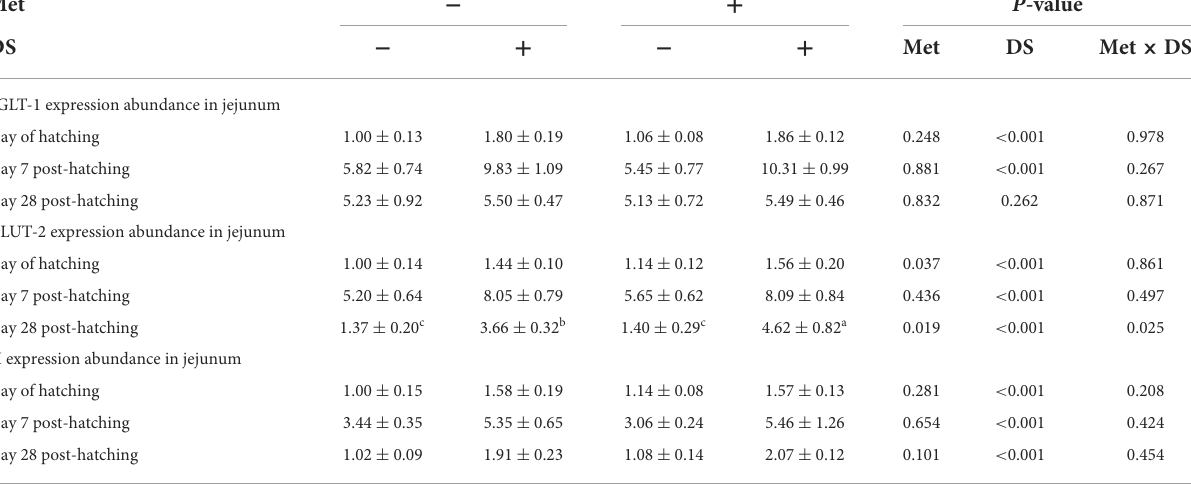
TABLE 12 Effects of in ovo injection of methionine (Met) and disaccharide (DS) on jejunum nutrients transport gene expression of geese during the early-life post-hatching 1,2 . Met